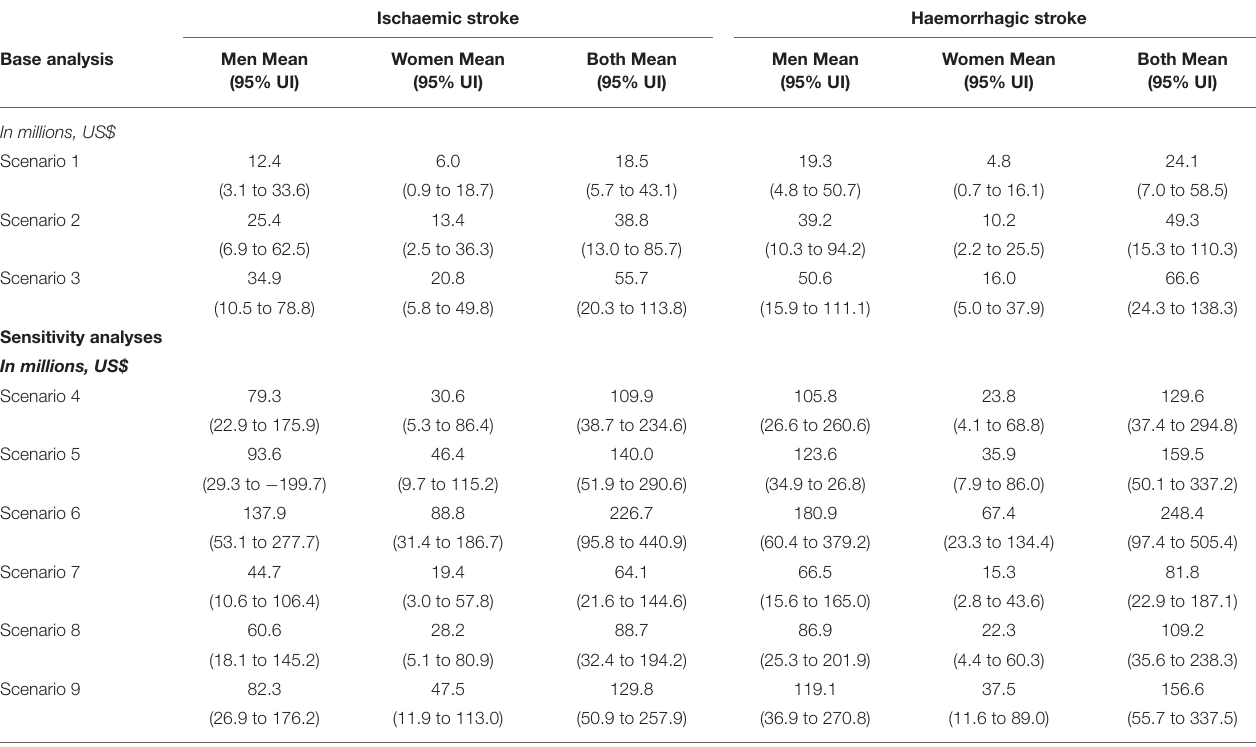
TABLE 4 | Projected healthcare costs saved from avoided incident strokes among adults in Vietnam from 2019 to 2030 and over the lifetime. Ischaemic